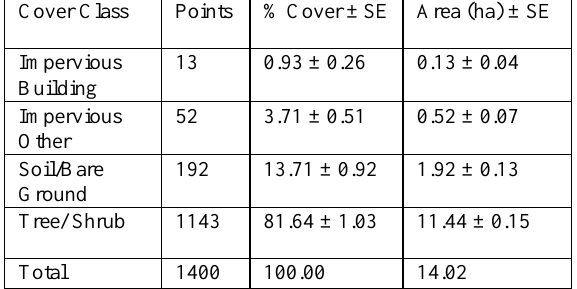
Table 5 . Land cover classes of Arapsuyu cemetery. The CO clearance amount of the Andızlı cemetery was estimated to be 16.62 kg, the NO 2 removal amount to 77.38 kg and the O 3 removal amount to 732.63 kg (Table 6).